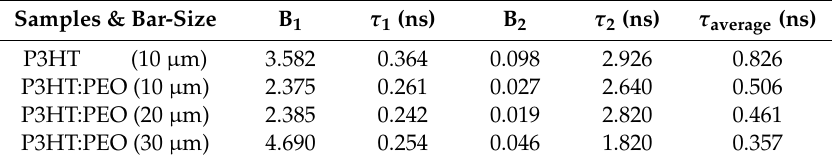
Table 1. The fitting results of P3HT film and P3HT: PEO film with different bar sizes. Samples & Bar-size B 1